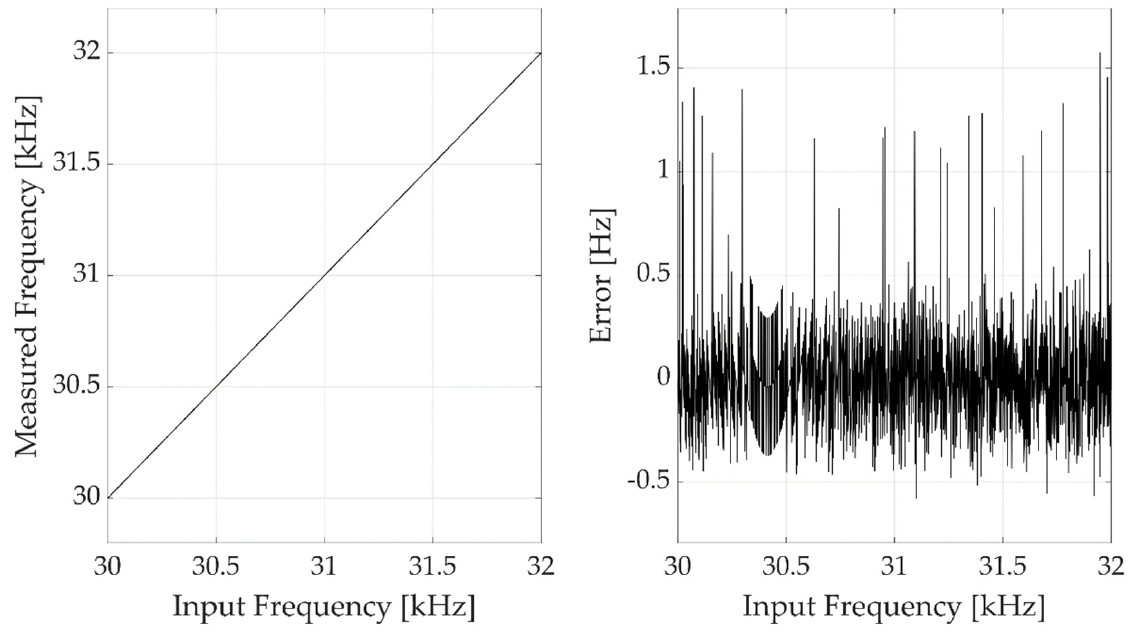
Figure 6. Measurement results observed directly providing to the FPGA digital frequency meter input square waves with fundamental frequencies in the range from 30 kHz to 32 kHz with a frequency step of 1 Hz, generated by a Rigol DG4162 waveform generator. The left plot shows the measured frequencies, the right plot shows the measurement error.